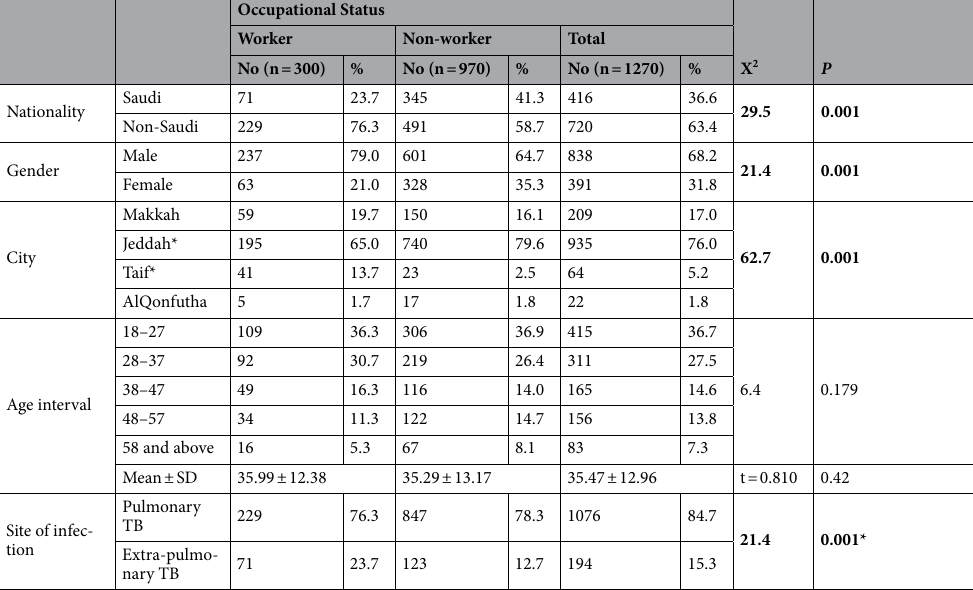
Table 2. Demographic distribution of TB cases according to occupational status among general population of Makkah region 2016. *Percent of workers differed from non-workers within this category using z-test of proportion adjusted for all pairwise comparisons within a row using the Bonferroni correction.